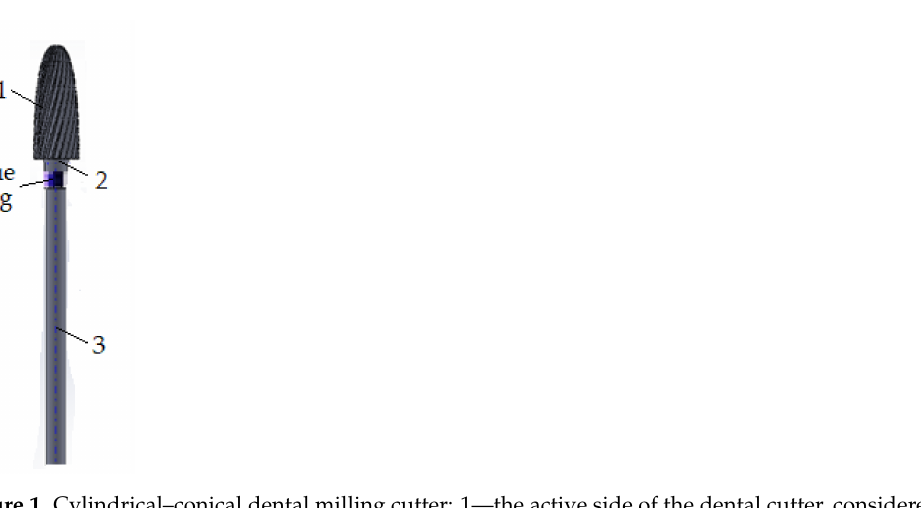
Figure 1. Cylindrical–conical dental milling cutter: 1—the active side of the dental cutter, considered as a standard; 2—cutter neck; 3—cutter leg.